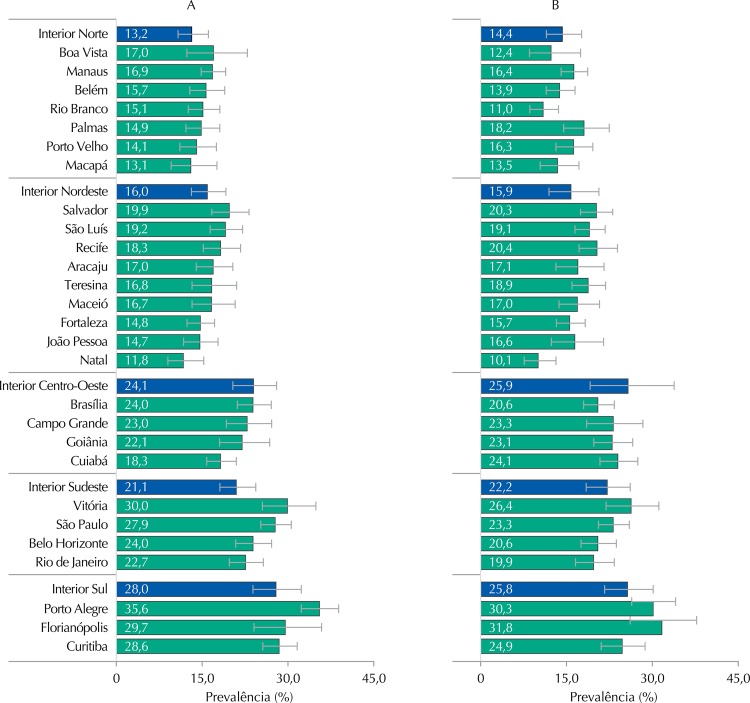
Prevalências e intervalos de confiança de consumo de álcool em adolescentes do sexo feminino (A) e masculino (B) por capitais. ERICA, Brasil, 2013-2014.